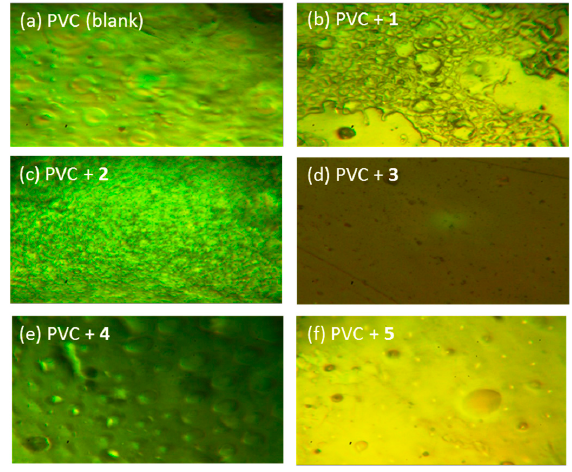
Figure 7. Microscope images for the non-irradiated PVC films (30 μ m thickness) with Schiff’s bases 1 – 5 (0.5% by weight) as additives.